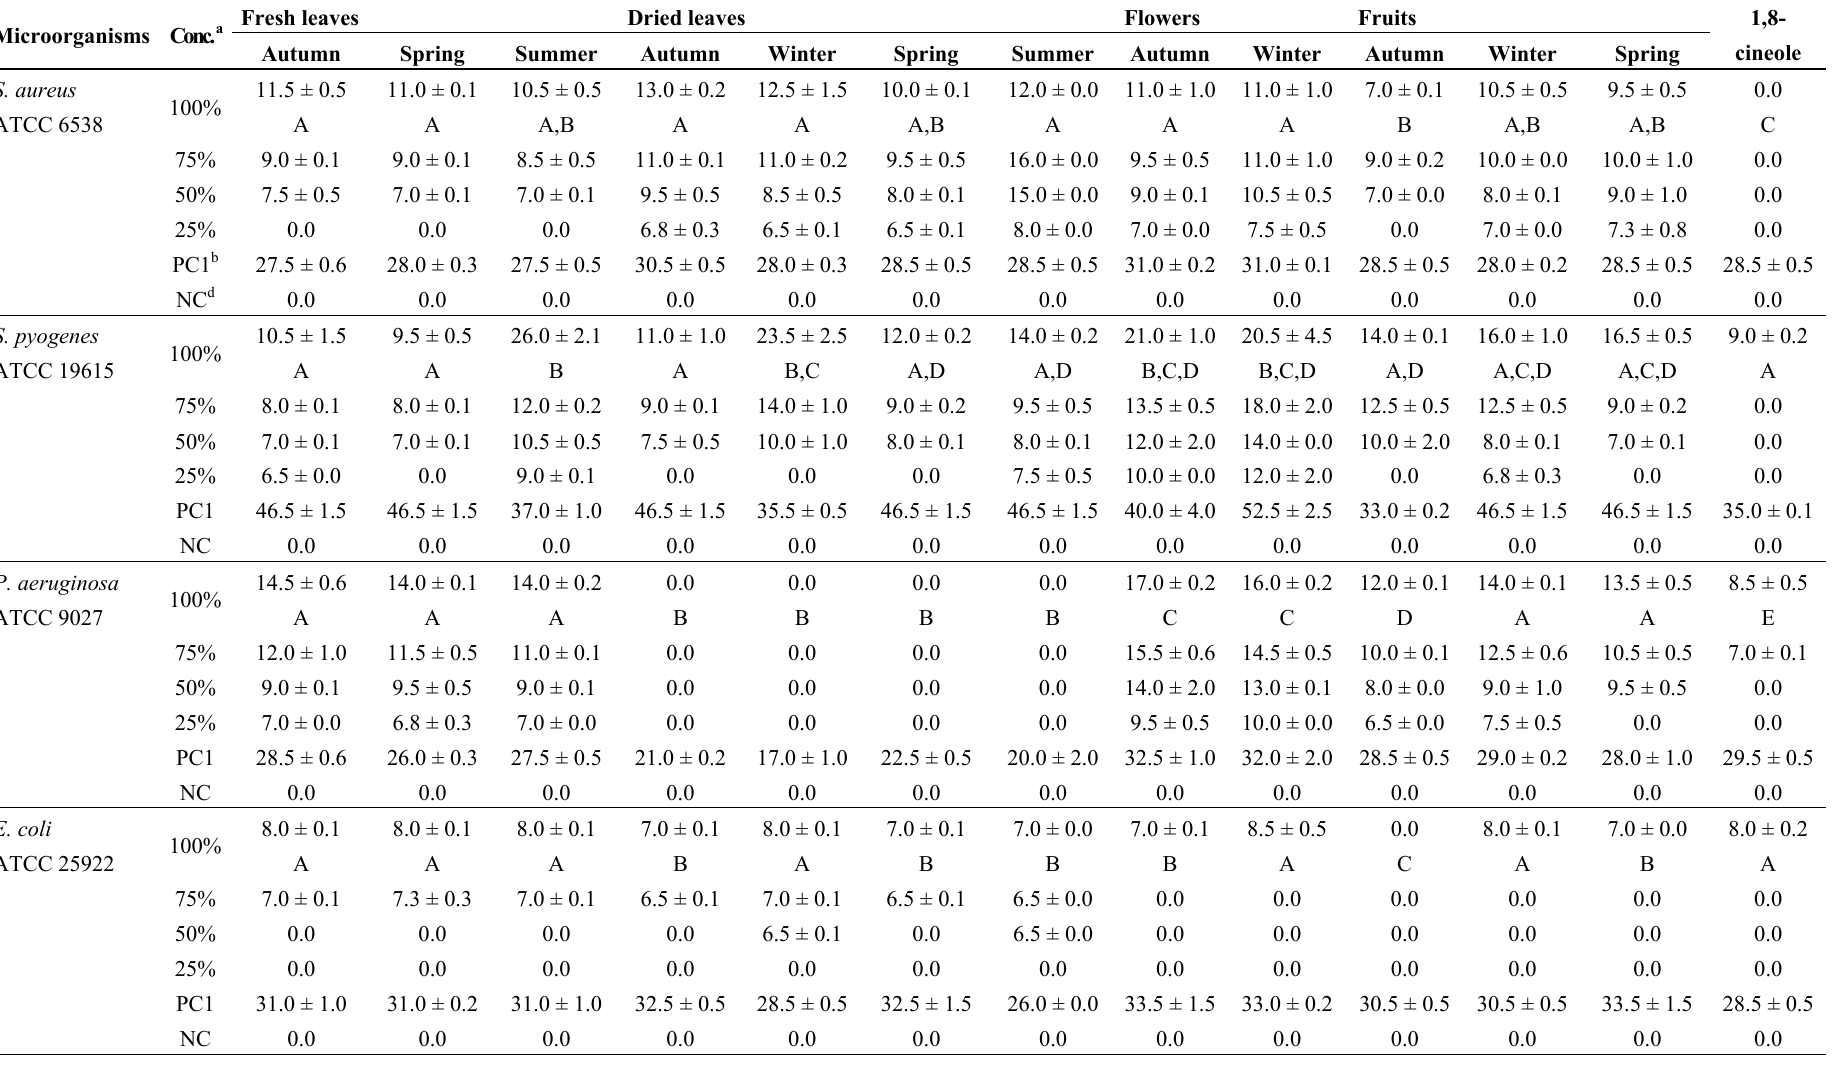
cineole Autumn Spring Summer Autumn Winter Spring Summer Autumn Winter Autumn Winter Spring